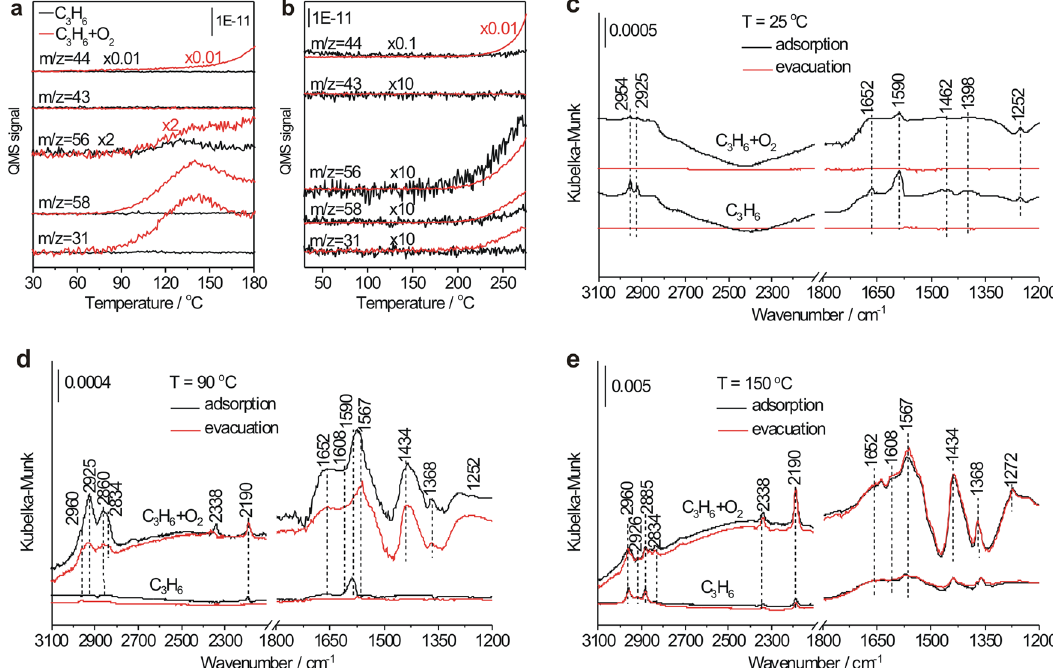
Fig. 3 Reaction mechanism. C 3 H 6 -TPRS (8% C 3 H 6 in Ar) and C 3 H 6 + O 2 -TPRS (8% C 3 H 6 + 4% O 2 in Ar) of a c-Cu 2 O-27 and b d-Cu 2 O-439 NCs. DRIFTS spectra of